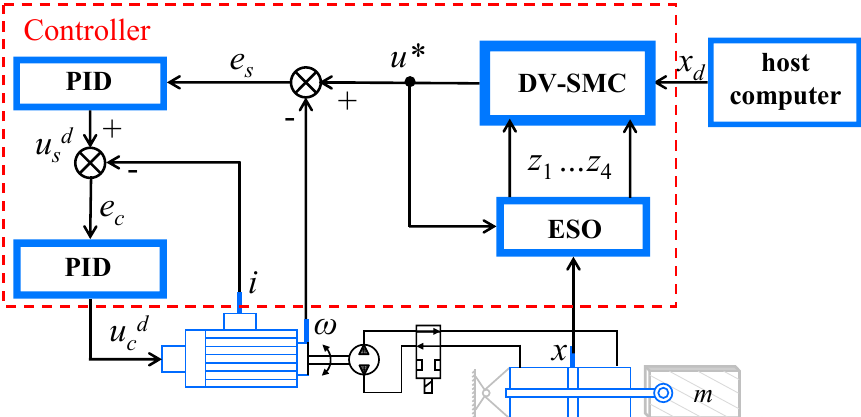
Figure 3. Block diagram of cascade control structure.